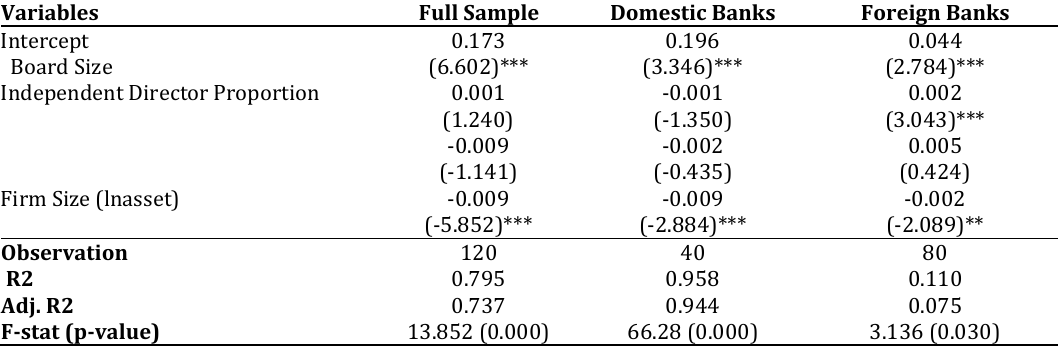
Table 10: The Regression Models for Asset Utilization ratio (AU) Variables Full